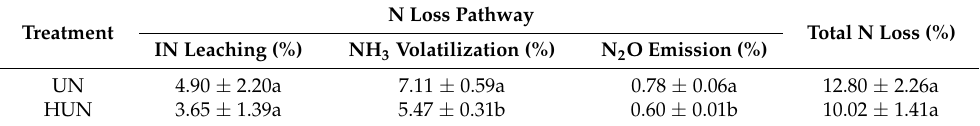
Table 1. The effects of different treatments on nitrogen loss in nitrogen fertilizer.